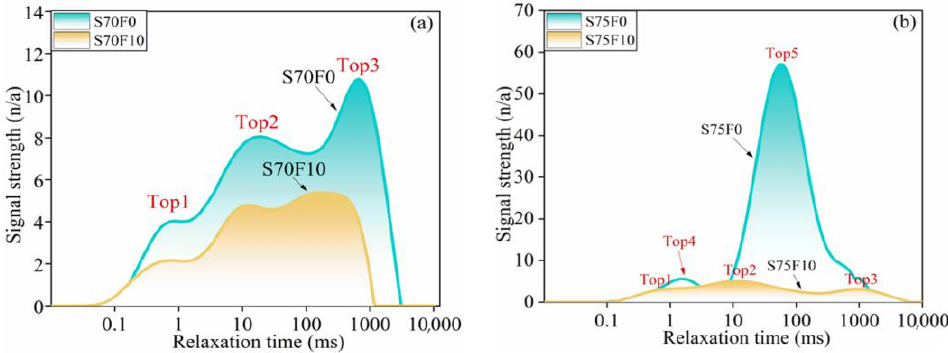
Figure 13. T 2 spectrum of specimens ( a ) S70F0 and S70F10; ( b ) S75F0 and S75F10.